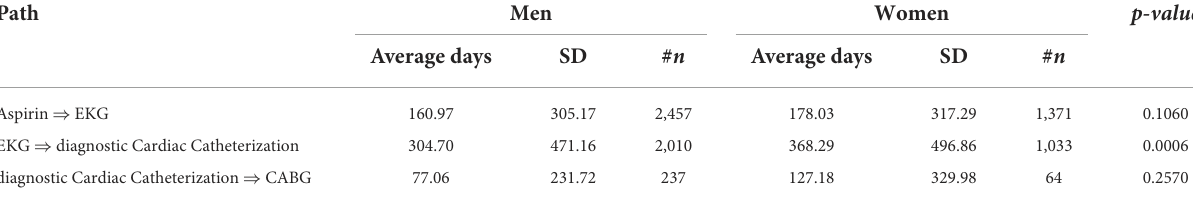
TABLE 3 Example of gender-based time interval calculation for individual pairs of event in the